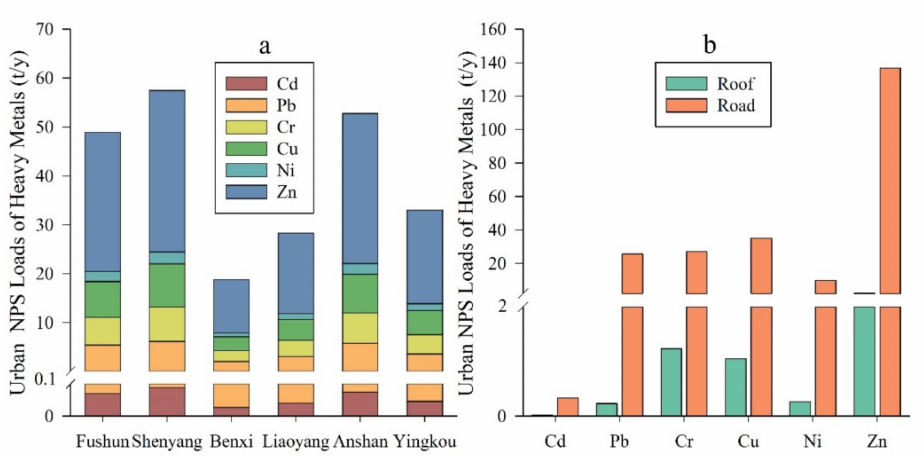
Figure 10. The urban non-point source (NPS) pollutant loads of six heavy metals (Cd, Pb, Cr, Cu, Ni, and Zn) in the six cities and different underlying surfaces. ( a ) The average annual pollutant loads of six heavy metals in the six cities; ( b ) The average annual pollutant loads of six heavy metals from roofs and roads.